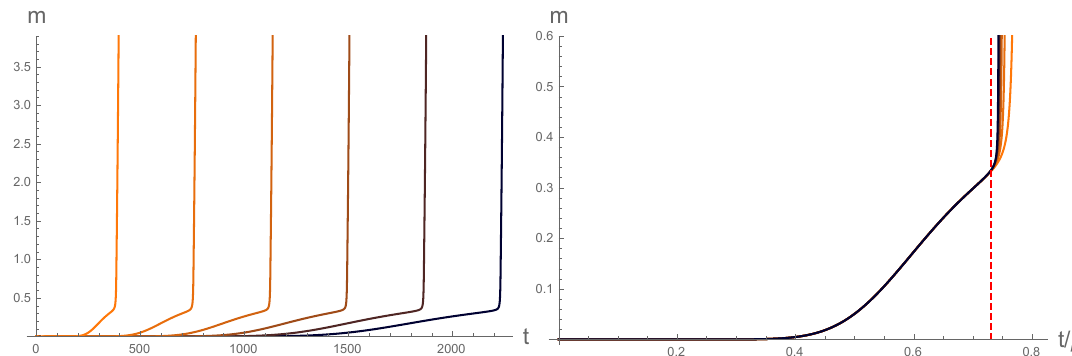
Figure 12 . Left: time evolution of the energy density for the quench processes described in the main text. From left to right, the quench time span corresponds to (cid:12) = 500 ; 1000 ; 1500 ; 2000 ; 2500 ; 3000. Right: time evolution of the energy density, now plotted against the scaling variable t=(cid:12) . We clearly observe that, prior to the adiabaticity breaking, m ( t=(cid:12) ) approaches a limiting curve as (cid:12) increases. The vertical line marks the time t (cid:3) =(cid:12) = (cid:17) = 0 :